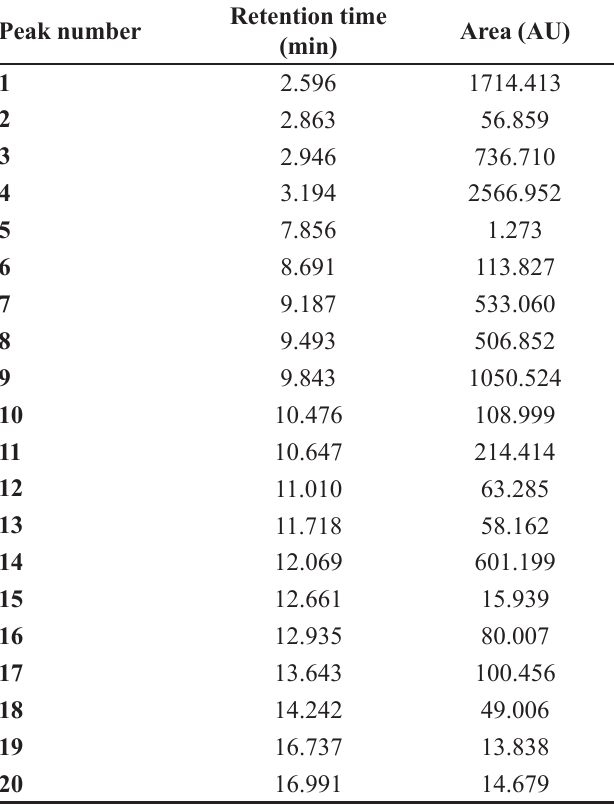
TABLE I - HPLC profile of methanolic fraction obtained from Lepista sordida Peak number